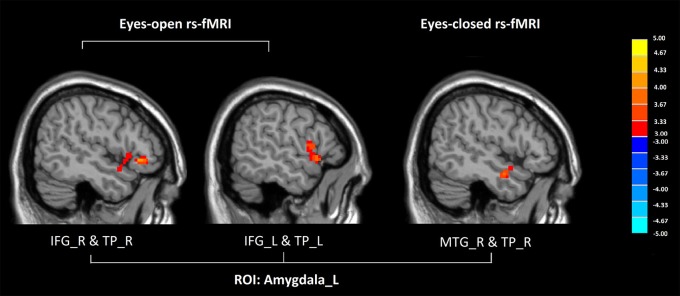
Altered functional connectivity seeded from the left amygdala in GAD, compared with HC (P < 0.005 to define cluster, AlphaSim correction, cluster size >53 voxels, overall p < 0.05). Hot colors indicate increased functional connectivity in GAD compared with HC. (GAD, generalized anxiety disorder; HC, healthy control; rs-fMRI, resting state fMRI; IFG, inferior frontal gyrus; TP, temporal gyrus; MTG, middle temporal gyrus; L, left; R, right).